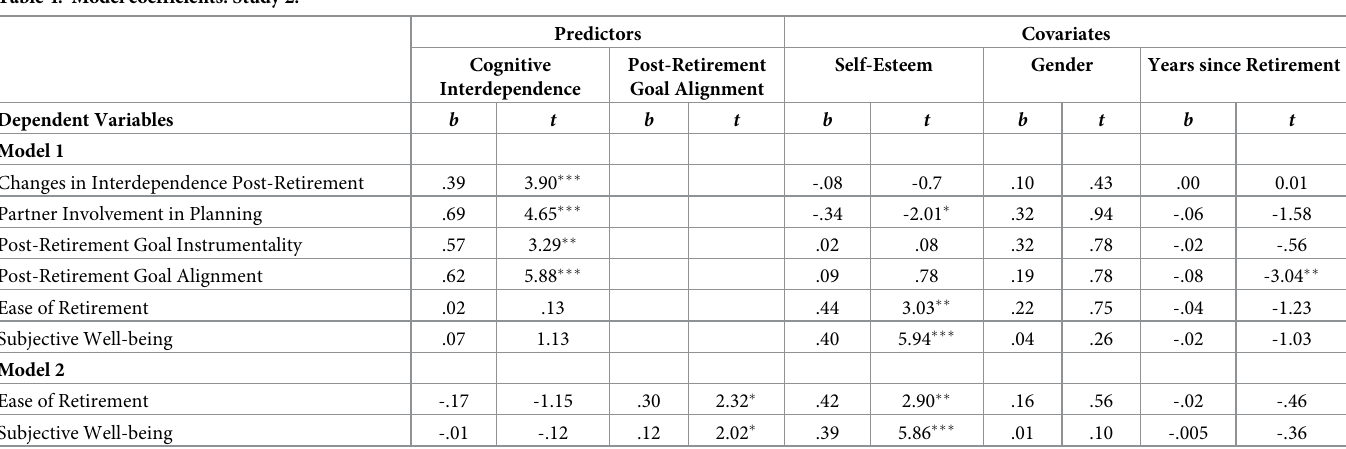
Table 4. Model coefficients: Study